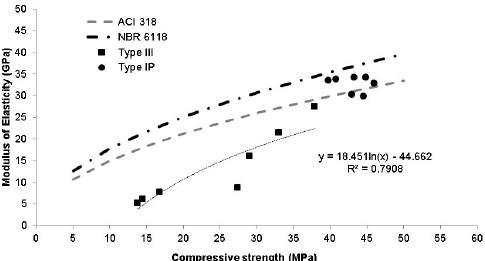
Figure 11. Correlation between the experimentally results of modulus of elasticity and compressive strength with the estimated results from Brazilian standard code ABNT NBR 6118:2014 [56] and ACI 318:2014